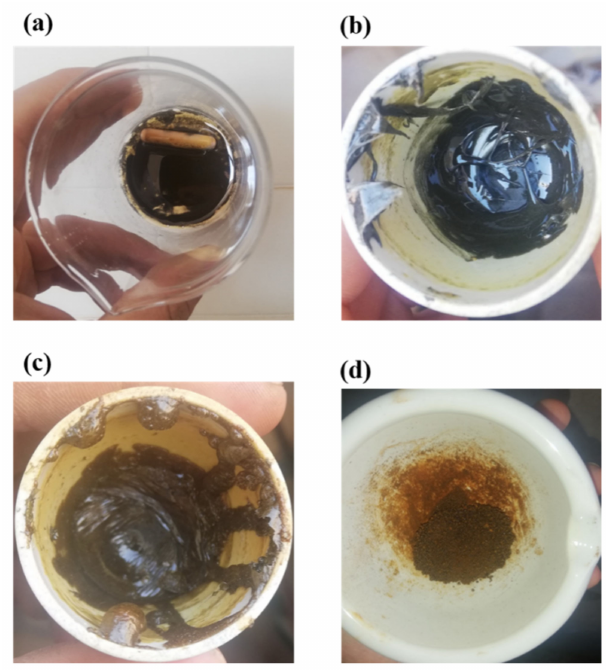
Figure 3. PFR embedded TiH 2 preparation stages: ( a ) stirred solution containing BPR resin and TiH 2 powder, ( b ) jelly-like and soft blend, ( c ) fragile and glassy blend, and ( d ) dark yellow powder after fast milling.